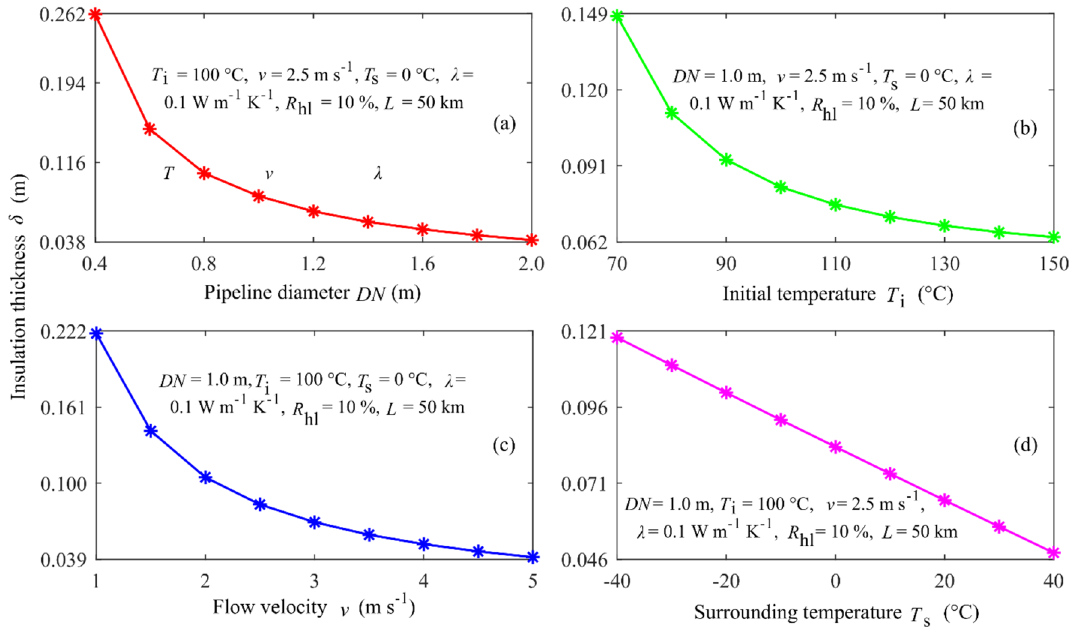
Fig. 5 Feasible insulation thickness for the pipeline